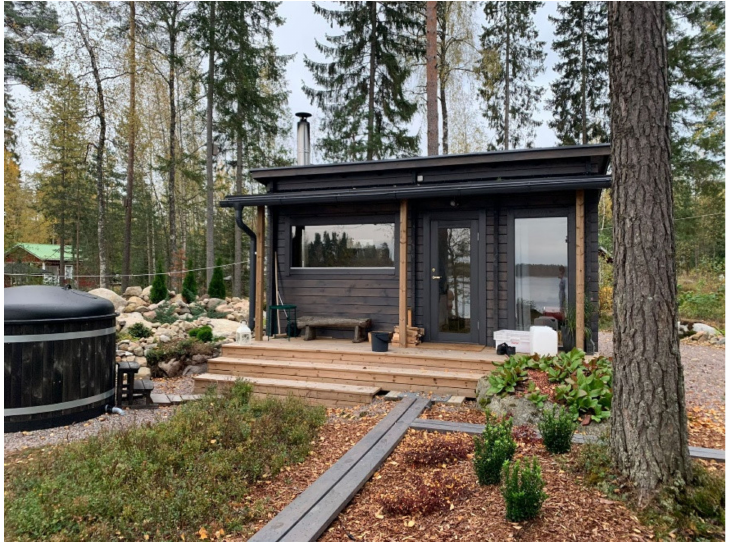
Figure 1. A recently built separate sauna building in Finland (Photo courtesy of Lotta